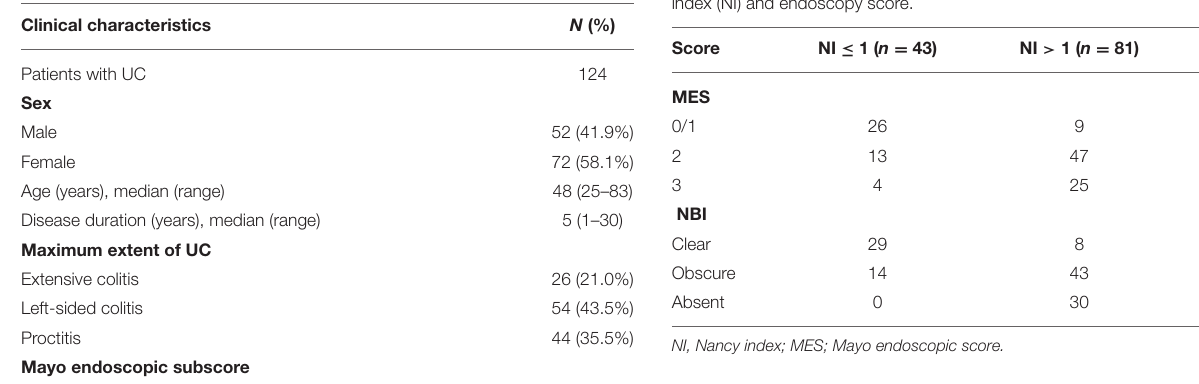
TABLE 1 | Clinical characteristics of patients with ulcerative colitis (UC).